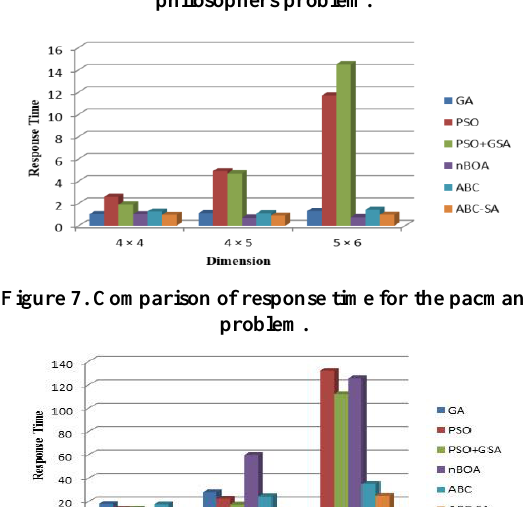
Figure 6. Comparison of response time for the dining philosophers problem.